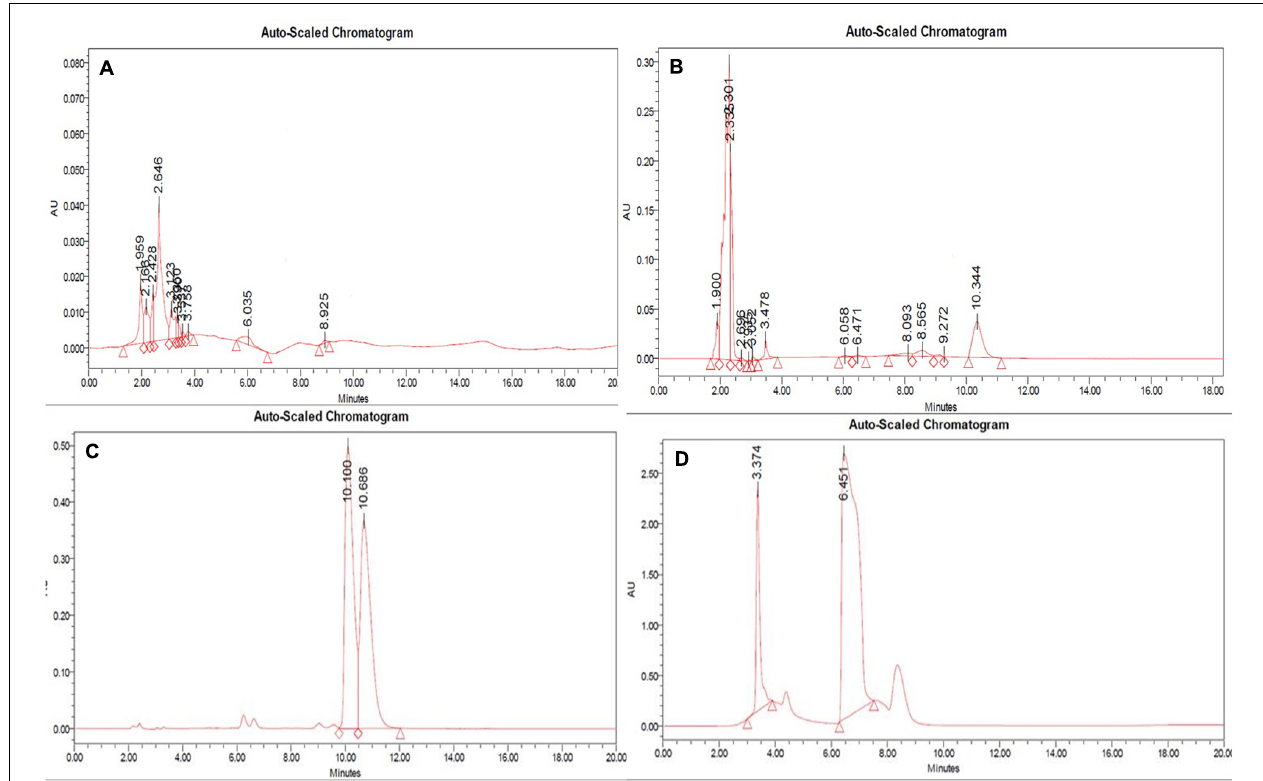
FIGURE 5 | RP-HPLC (A) non-treated, (B) 100 nM BRD4770-treated crude metabolite of D. longicolla , (C) berberine standard, and (D) caffeine + theobromine standard.